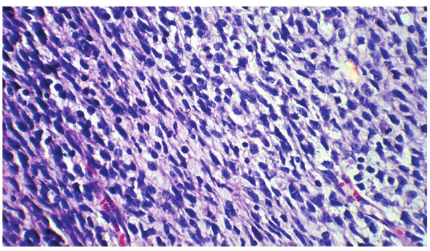
Figure 1: Soft tissue sarcoma with numerous mitotic figures (H&E × 400).